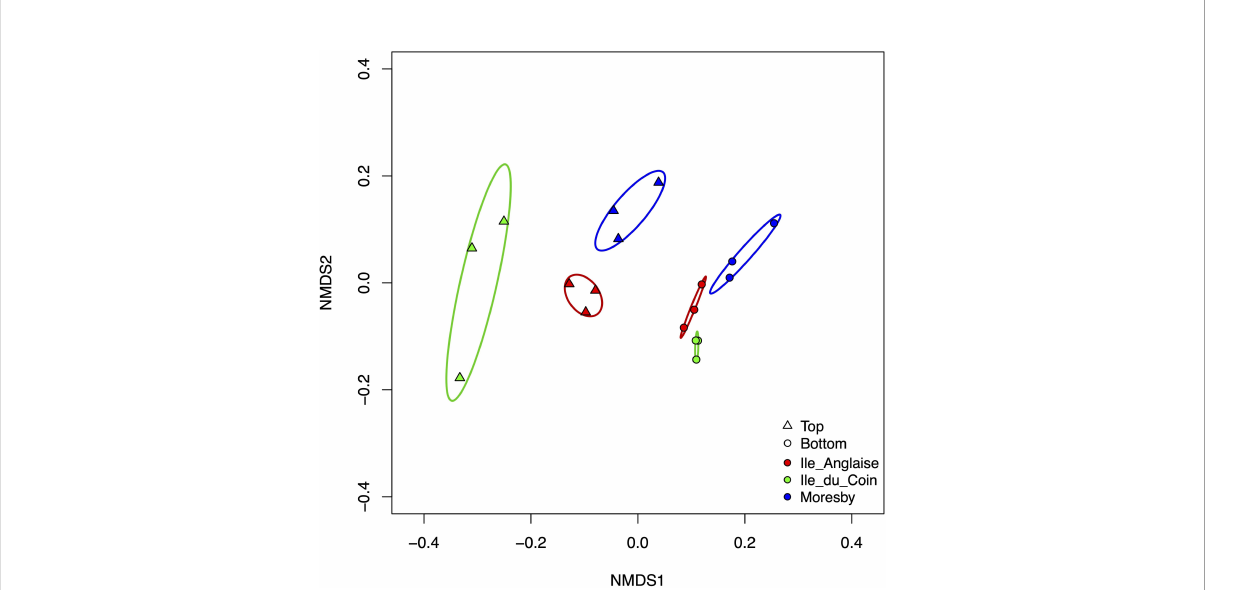
FIGURE 6 Non-metric multidimensional scaling (NMDS) ordination plots of autonomous reef monitoring structures (ARMS) communities on top or bottom plate faces across sampling sites, based on Bray – Curtis distances using fourth-root transformed count data and over two reduced dimensions